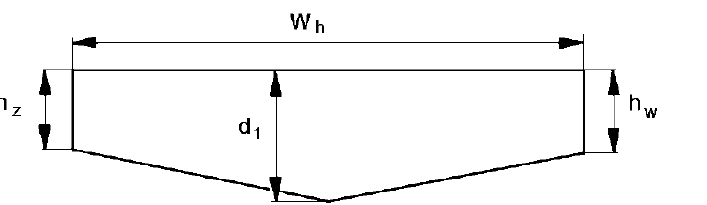
Figure 13. The diagram of a cross-section of the cut obtained by mining with a symmetrical disk tool assisted by two HPW jets located on the sides of the disk tool [1].